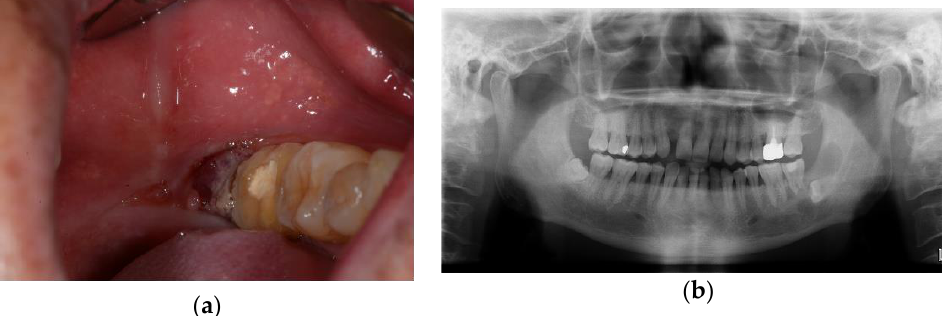
Figure 5. Initial examinations: ( a ) intraoral photograph showed the granulomatous lesion on the left retromolar triangle; ( b ) panoramic view showed the impacted tooth and multilocular radiolucency lesion.